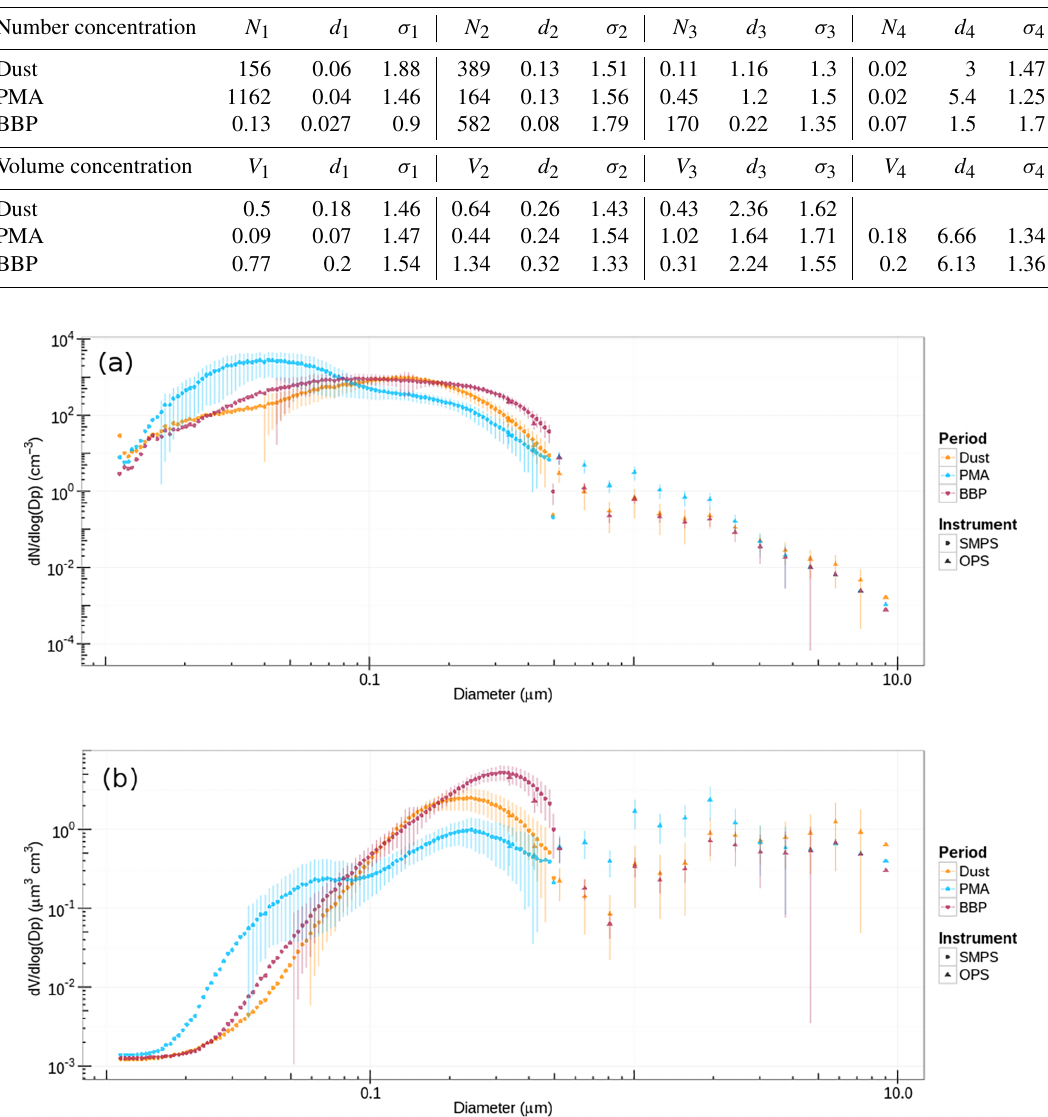
Figure 12. Number (a) and volume (b) size distribution averaged by periods of dust, PMA, and BBP using the SMPS and OPS instruments. The dry diameters range 10nm to 10µm. The first and last days of each period were removed to capture the main feature and the maximum amplitude of the